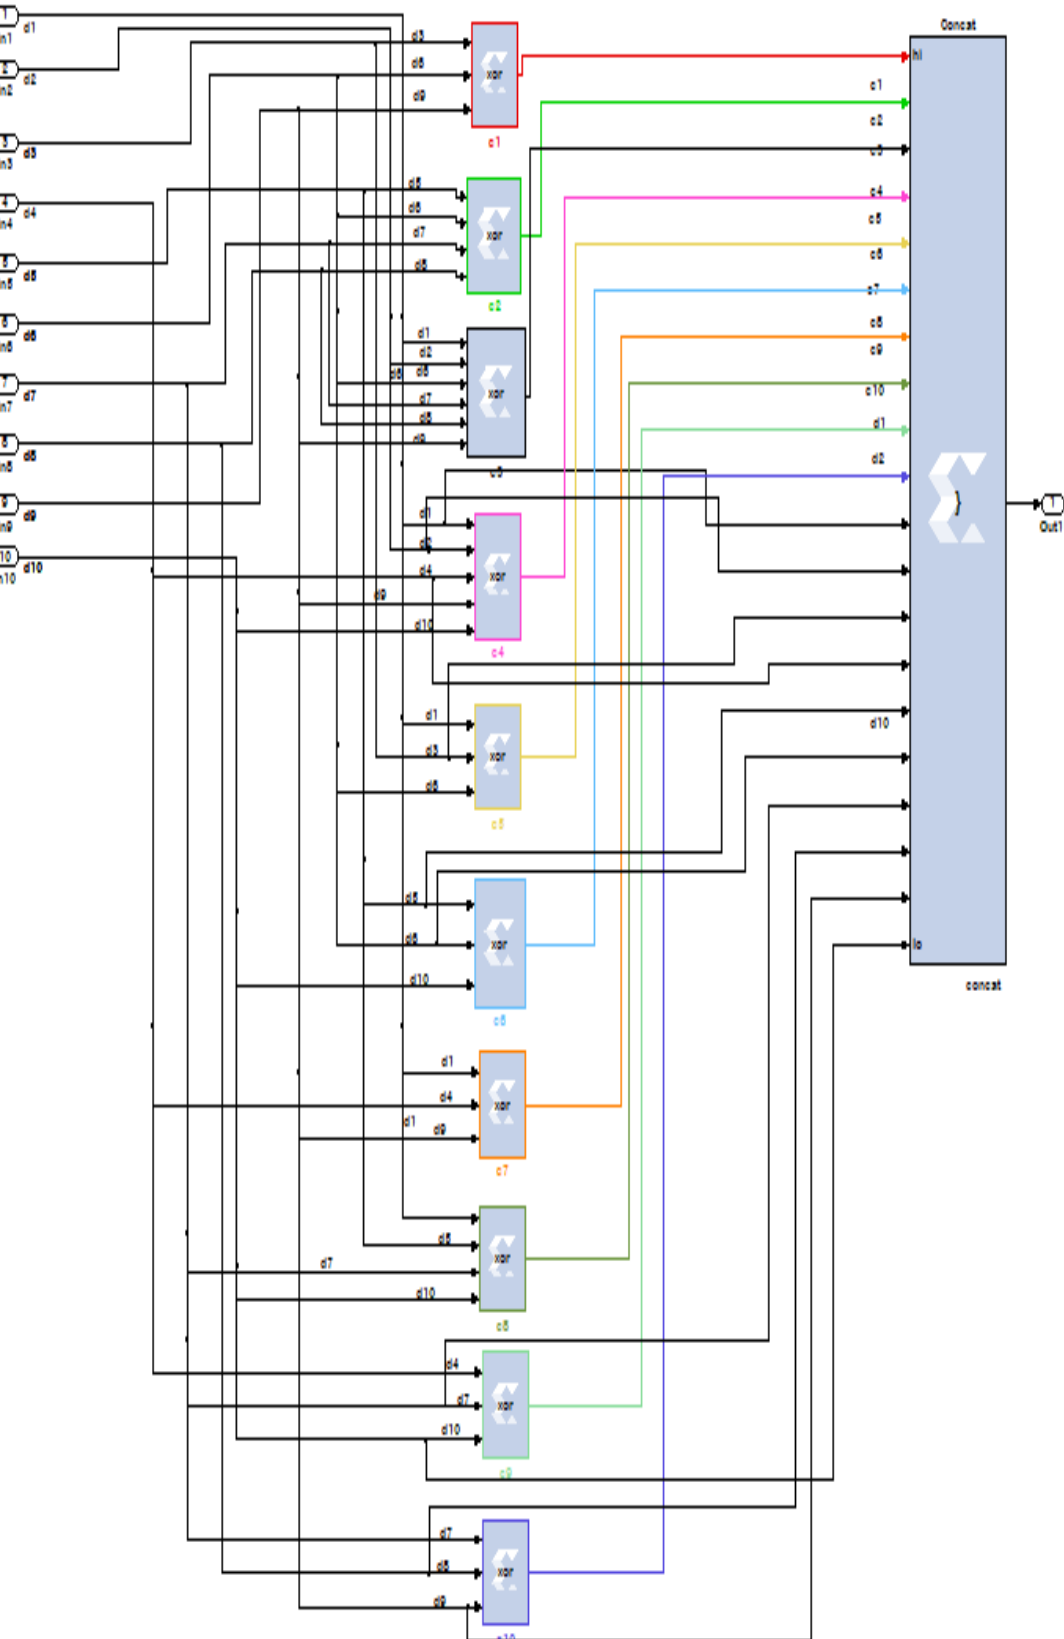
Fig. 5. The Xilinx SG block diagram of Encoder